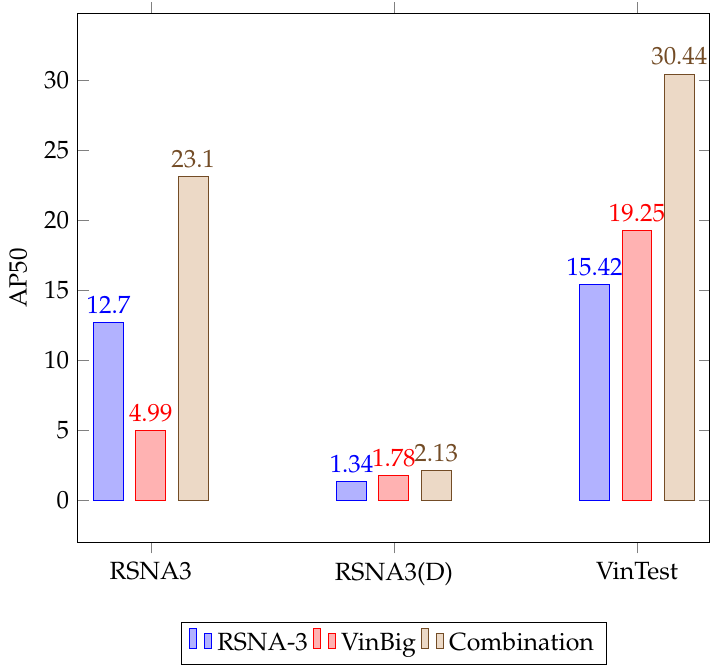
Figure 9. Pneumonia detection performance comparison. Table 2. Pneumonia detection training on RSNA-3.